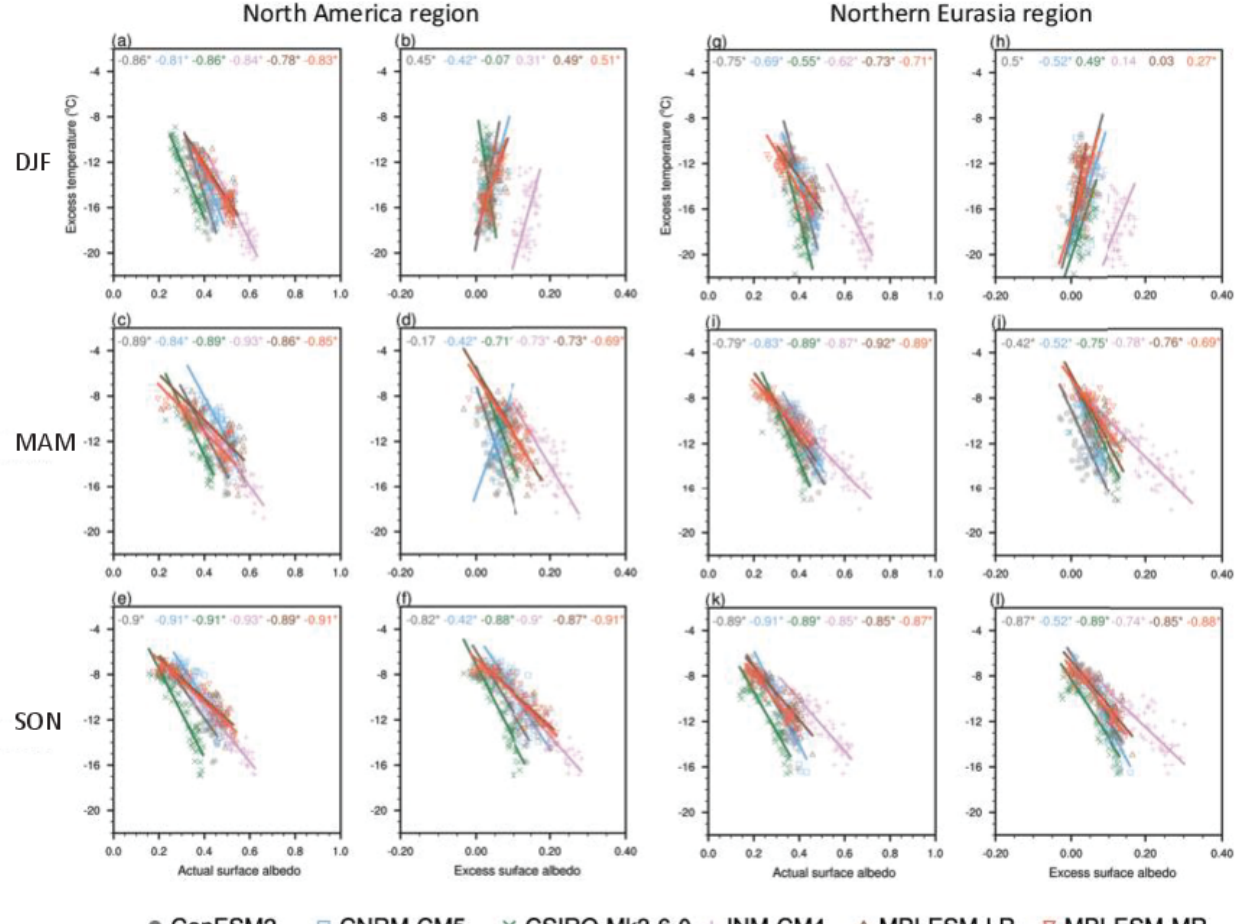
cover shown for the Nordic countries and central or eastern Europe, with no substantial changes in Siberia (Fig.